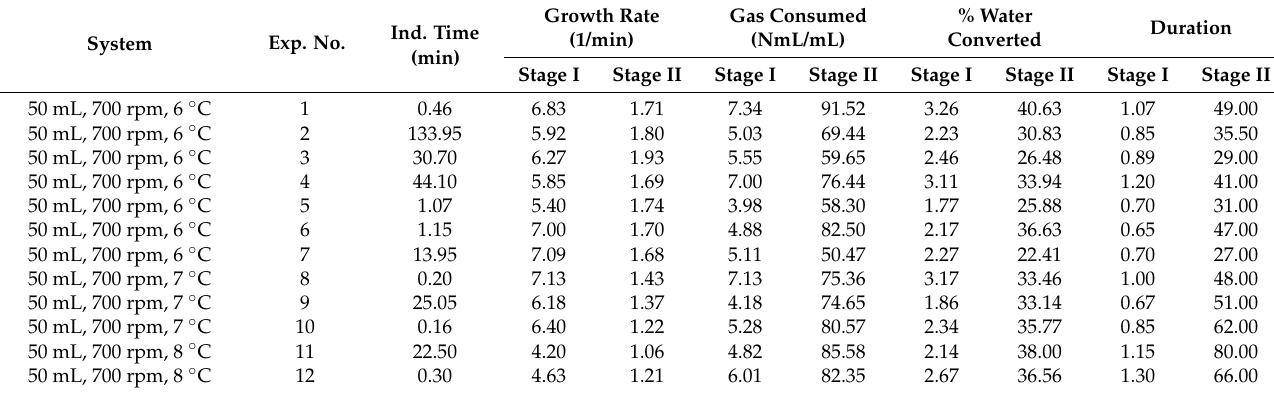
Table 5. Summary of results including total gas consumption and percentage water converted to hydrate at the end of growth stage II, and induction time measurements for each experiment (141.4 mL